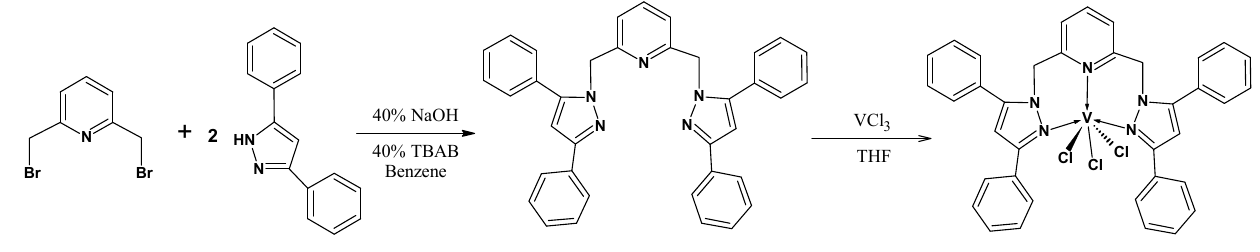
Table 1. Crystal data and structural refinement parameters of 2,6-[(3,5-ph